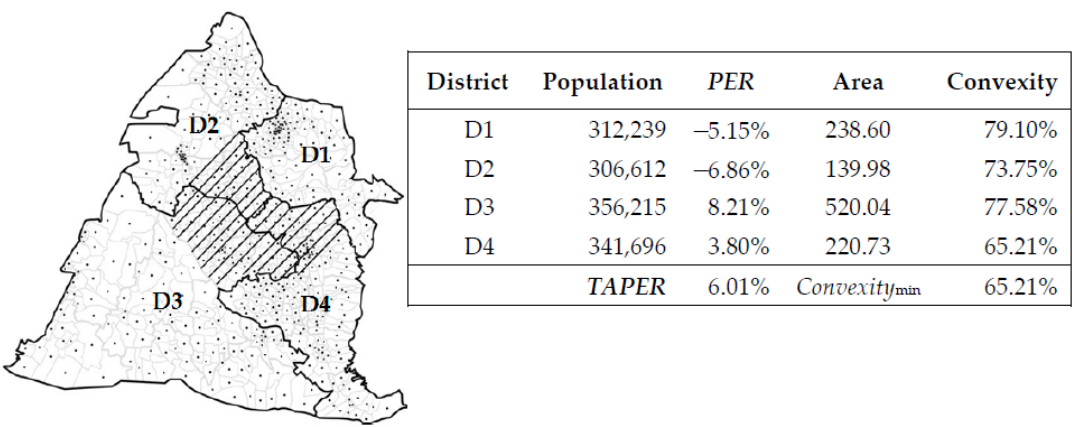
Figure 7. Electoral districting and relevant information revealed from the official version.